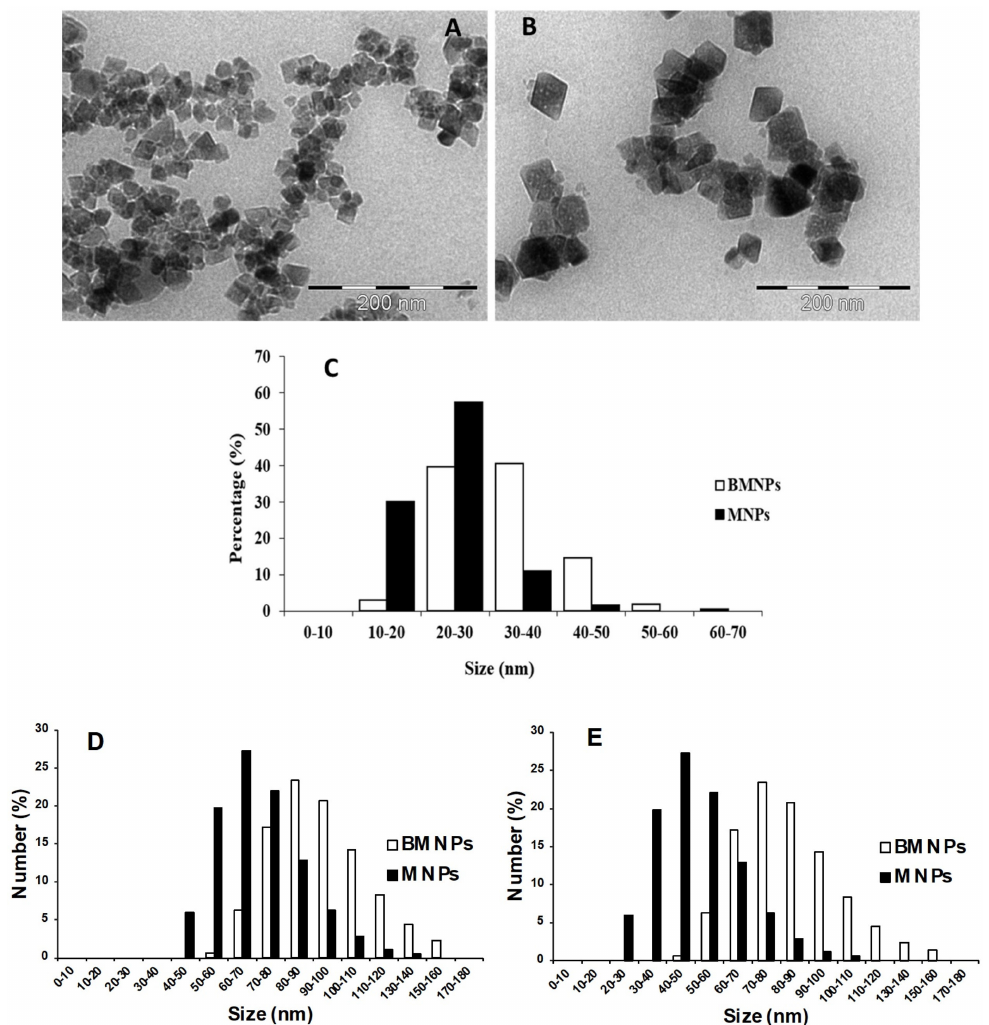
Figure 1. TEM images of MNPs ( A ) and BMNPs ( B ) (Scale bar = 200 nm.). ( C ) Size distribution of MNPs and BMNPs according to TEM analysis. Size distribution according to DLS data of BMNPs and MNPS resuspended in PBS pH 7.4 ( D ) and cell culture medium ( E ). All the DLS measurements were performed in